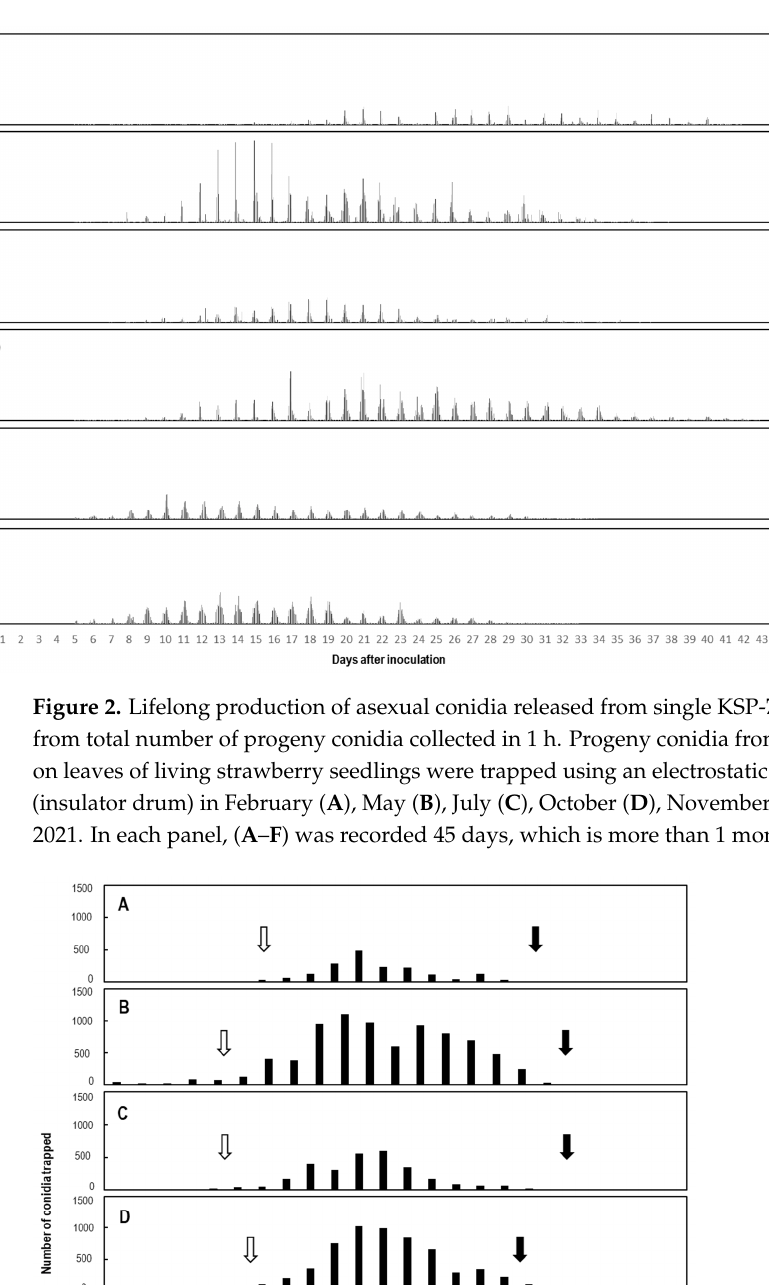
Figure 2. Lifelong production of asexual conidia released from single KSP-7N colonies was assessed from total number of progeny conidia collected in 1 h. Progeny conidia from single KSP-7N colonies on leaves of living strawberry seedlings were trapped using an electrostatic rotational spore collec- tor (insulator drum) in February ( A ), May ( B ), July ( C ), October ( D ), November ( E ), and December ( F ) in 2021. In each panel, ( A – F ) was recorded 45 days, which is more than 1 month. Table 1. Development of individual colonies of Podosphaera aphanis KSP-7N on leaves of strawberry seedlings during the period of conidiation by conidiophores, assessed by direct counting of progeny conidia consecutively trapped on insulator films electrostatically activated.